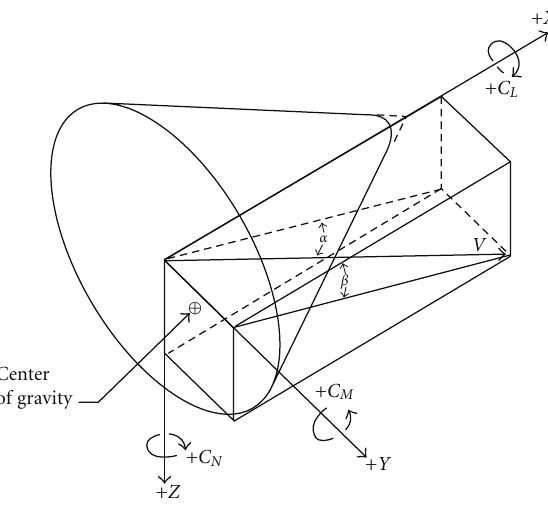
Figure 3: The reference frame and the aerodynamic angles for the